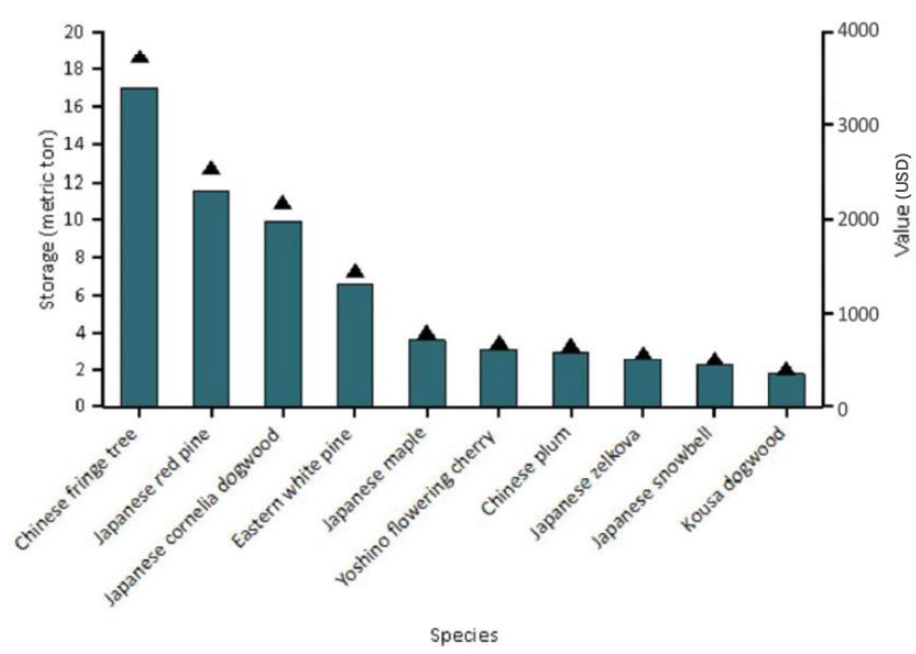
Figure 8. Estimated carbon storage and values for tree species with greatest storage. Triangle represent Removal.